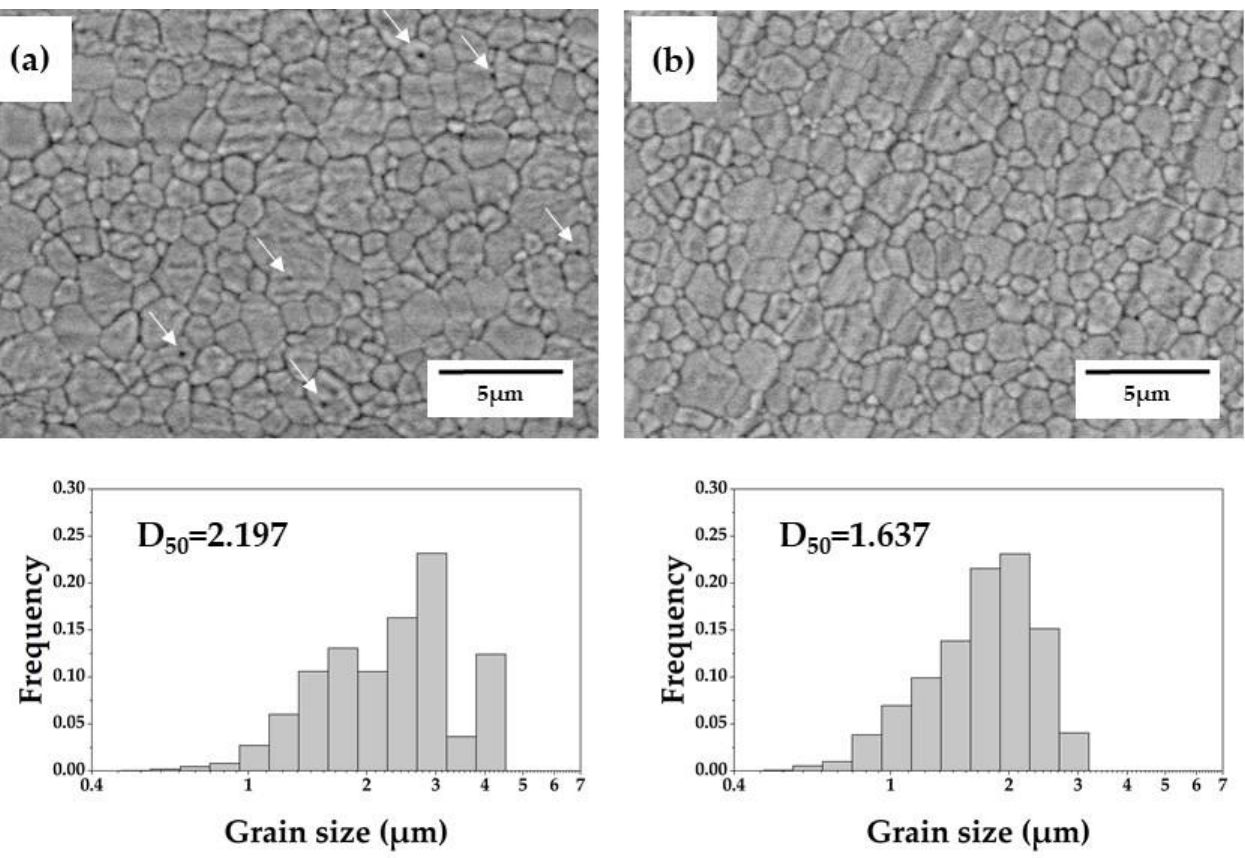
Figure 6. Scanning electron micrographs and grain size histograms of: ( a ) 5Y-SS-1.9, ( b ) 5Y-CS-1.9. Arrows in the micrograph indicate pores.